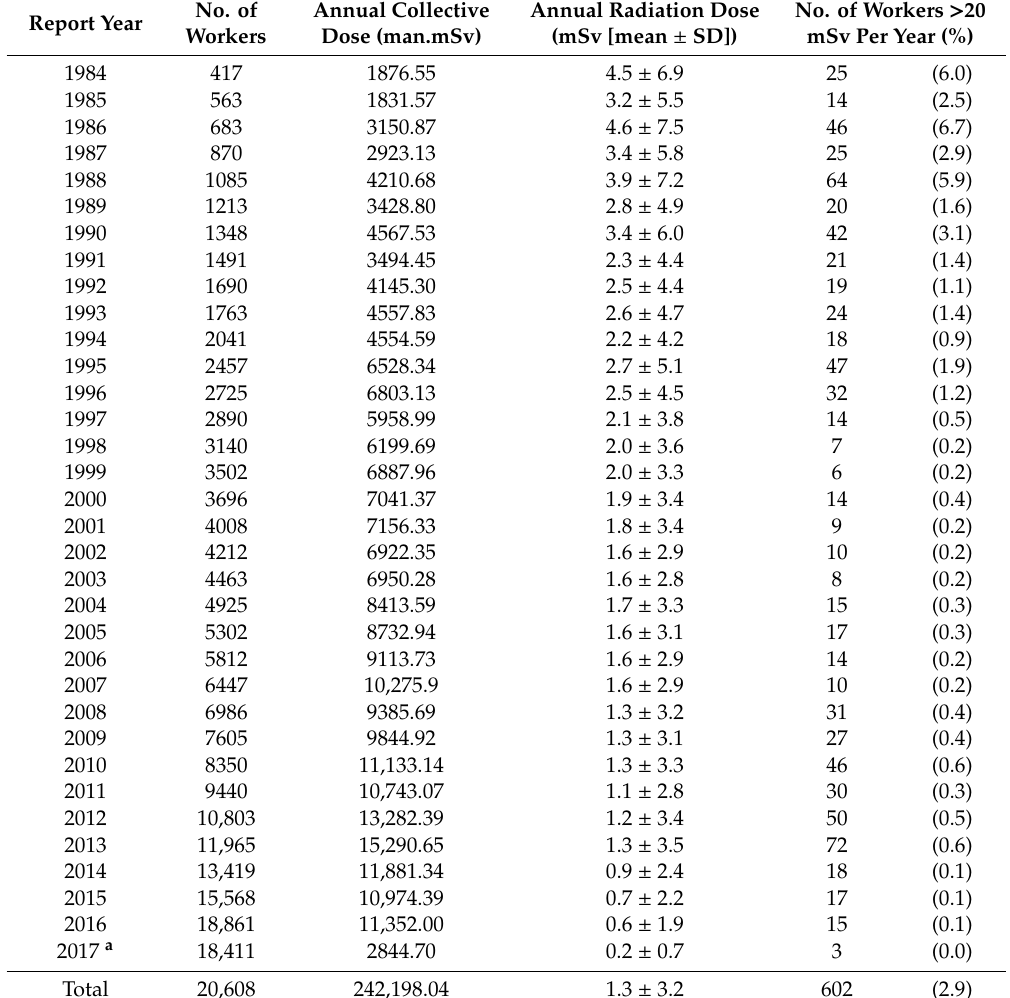
Table 3. Distribution of radiation doses ( H p (10)) and the number of workers receiving doses > 20 mSv per year, 1984–2017.